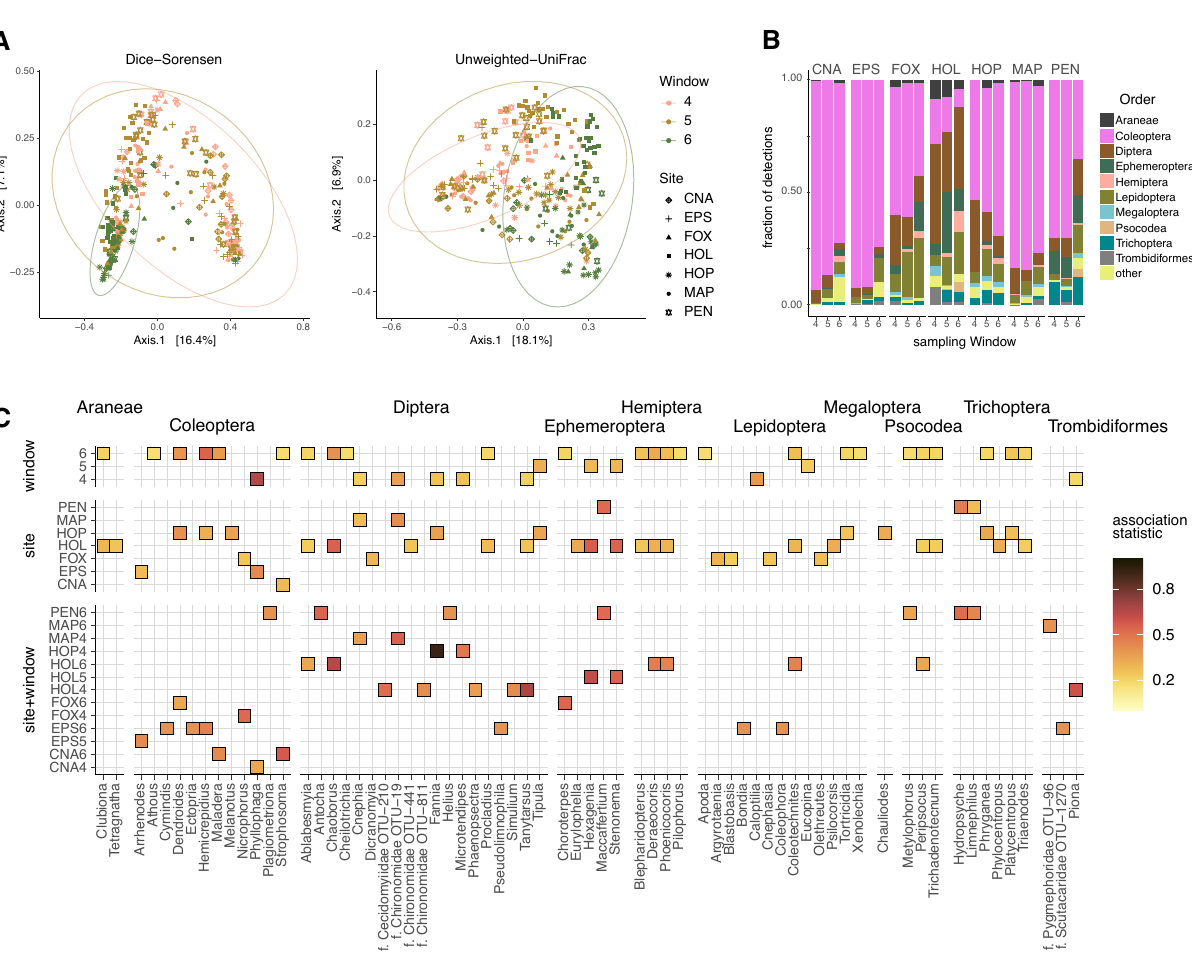
Figure 4. Changes in bat diet arthropod composition at multiple sites and sampling windows in 2016. ( a ) PCoA ordinations shown for Dice-Sorensen index and unweighted UniFrac distance metrics depict sampling site (point shape) or sampling window (color); ellipses depict 95% confidence intervals around window group median. ( b ) The proportion of detections per arthropod order in a sampling window for each site; arthropods with fewer than 2% of detections aggregated as “other” taxa. ( c ) Indicator species analysis performed at genus level to identify taxa associated with sampling window, or site, or site + window groups. Taxa with ambiguous genus labels identified by known arthropod family